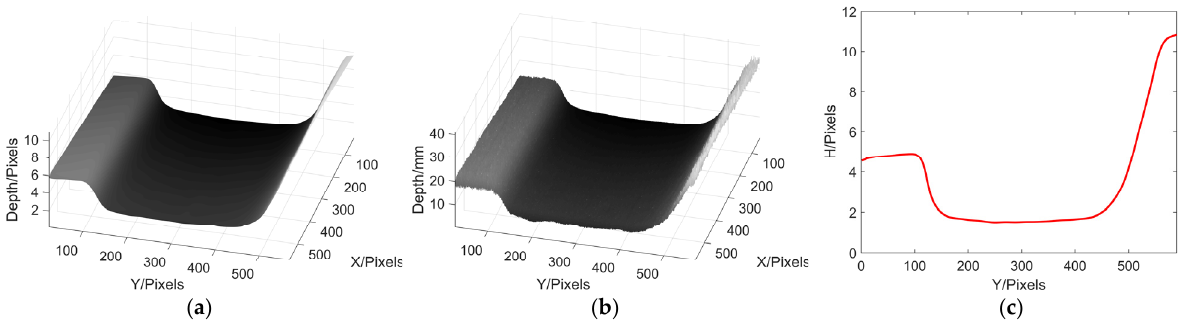
Figure 17. Experimental reconstruction results of rail. ( a ) phase reconstruction; ( b ) height reconstruction; ( c ) The cutaway of the 300th row.